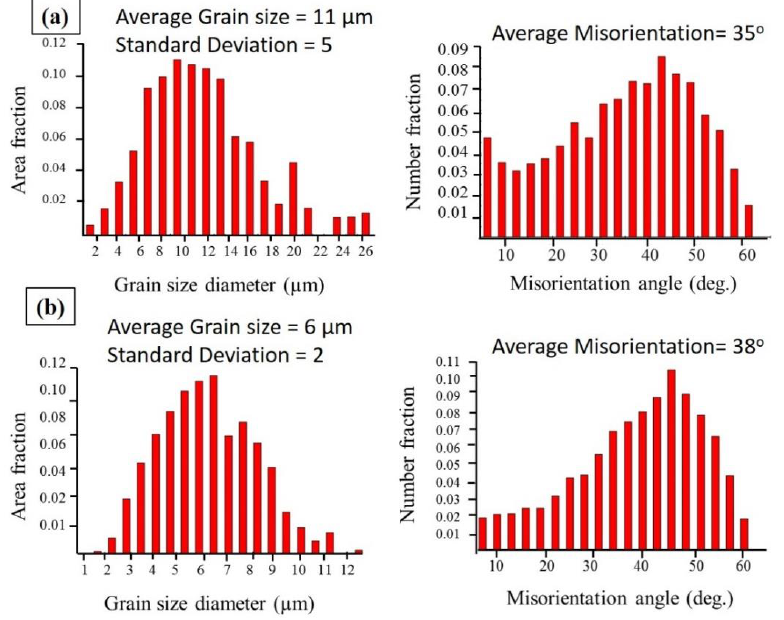
Figure 14. ( a ) Grain size and misorientation angle distributions of the dissimilar T-butt Friction stir welded joint, where ( a ) AA2024-T4 region and ( b ) AA7075-T6 region in the joint produced at 600 rpm.